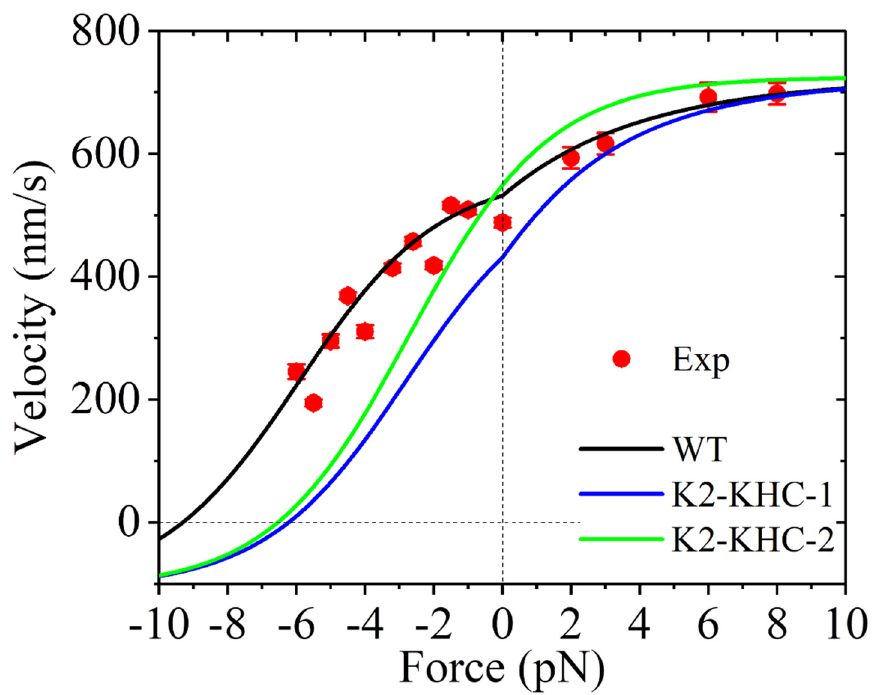
Figure 5. Dependence of velocity on backward and forward loads for mammalian kinesin-2 KIF3AB motors. Lines are theoretical results. Symbols are experimental data taken from Andreasson et al. [39]. WT and K2-KHC represent the wild type and the mutant one with its NL in each head being swapped with that of Drosophila kinesin-1 head, respectively. Table 3. Parameter values for kinesin-2 KIF3AB motors.